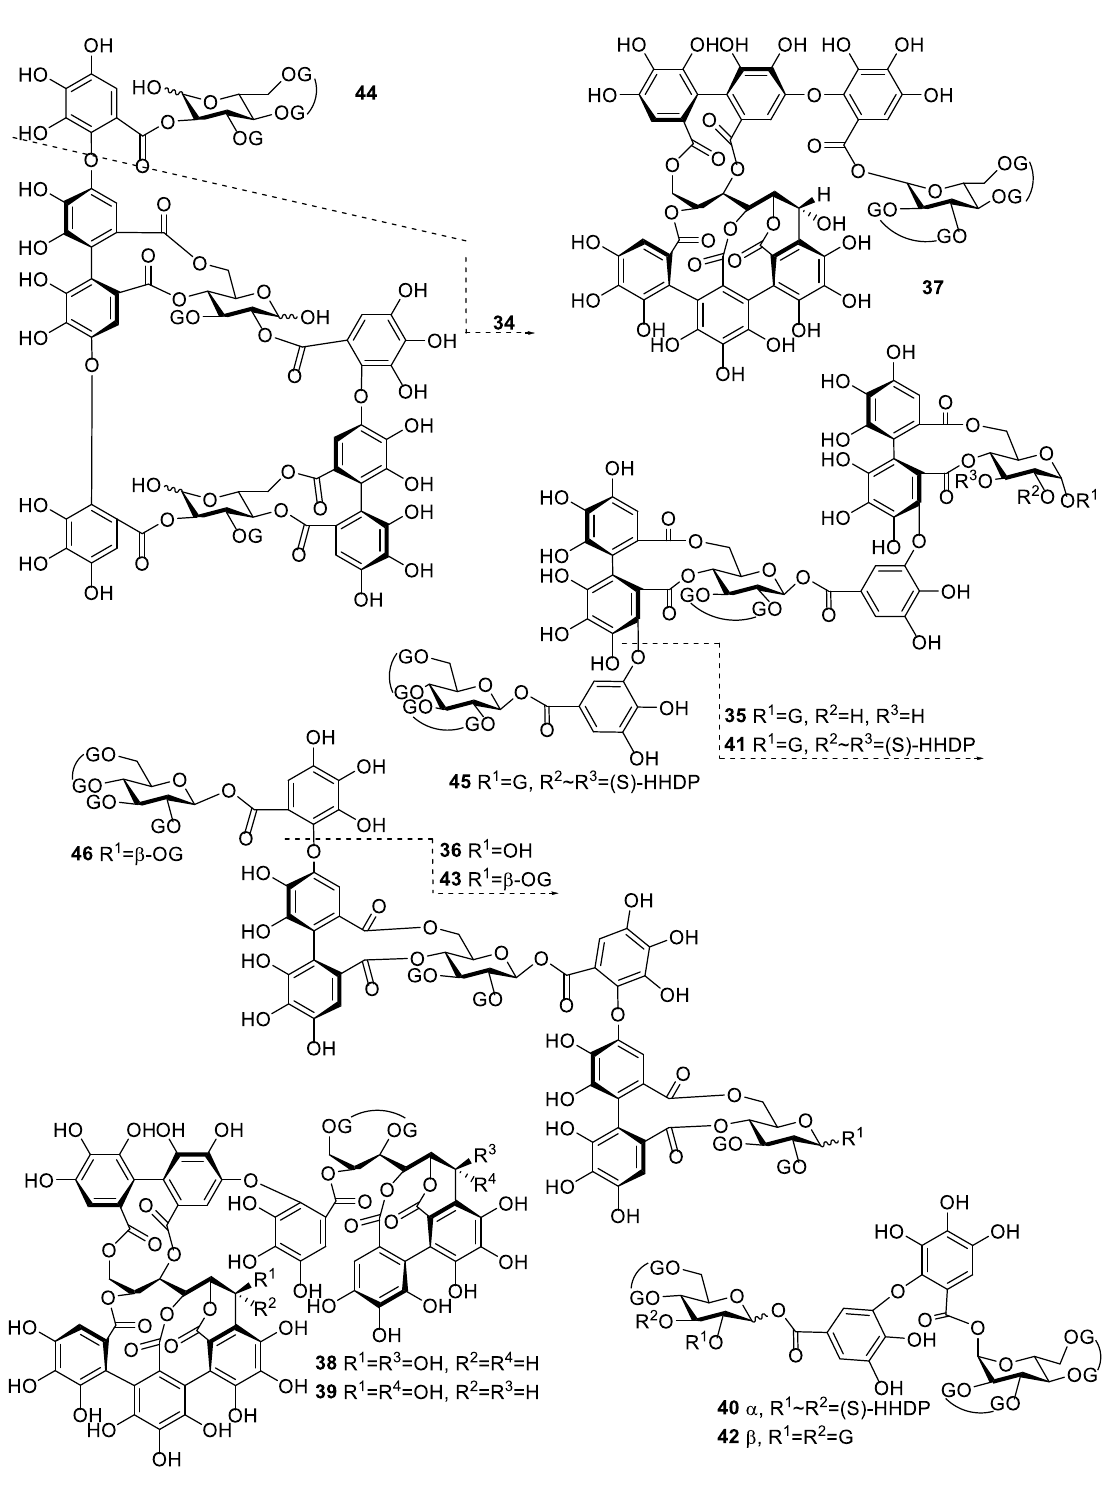
Figure 2. Chemical structures of oligomeric hydrolysable tannins used in the study. 34 oenothein B, 35 rosenin C, 36 rugosin E, 37 cocciferin D-2, 38 salicarinin A, 39 salicarinin B, 40 agrimoniin, 41 sanguiin H-6, 42 gemin A, 43 rugosin D, 44 oenothein A, 45 lambertianin C, 46 rugosin G. See Figure 1 for the details of substitute groups.